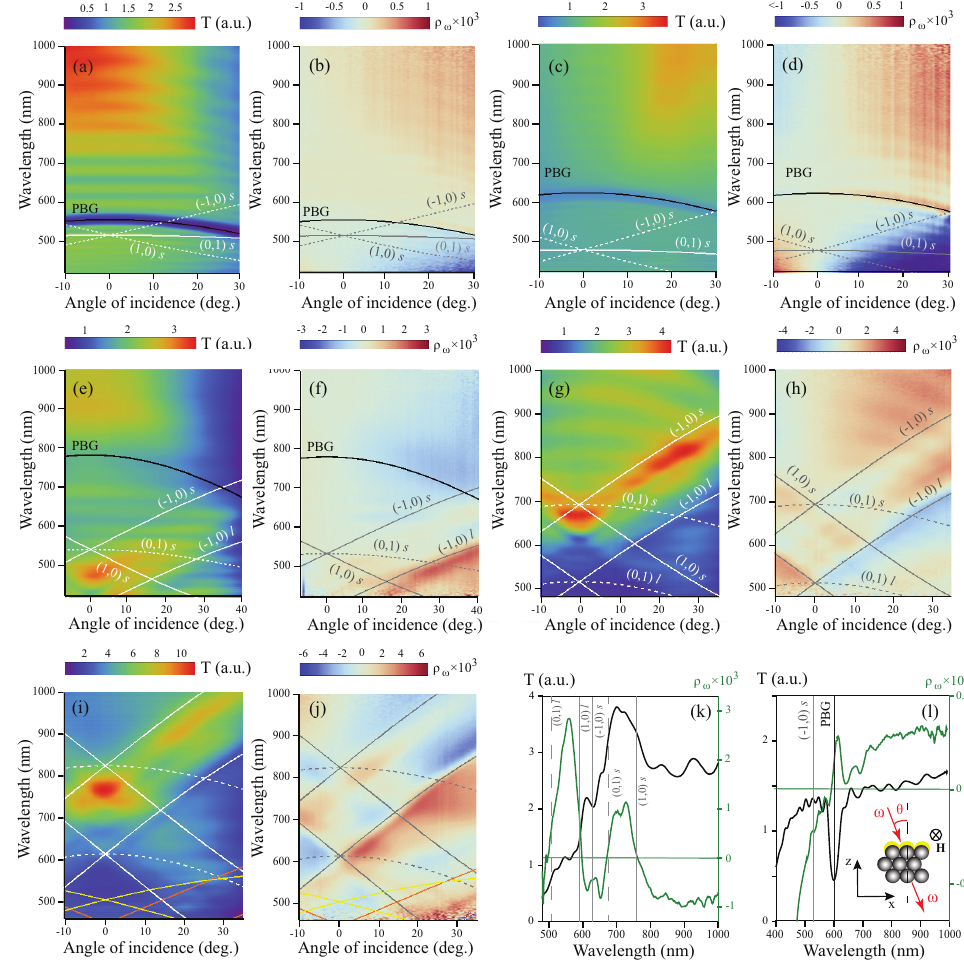
Figure 2. Angular-wavelength spectra of the transmission and magnetic contrast in the Voigt geometry for the samples “1” ( a , b ), “2” ( c , d ), “3” ( e , f ), “4” ( g , h ), and “5” ( i , j ); ( k ) T ( λ ) (black curve) and ρ ( λ ) (green curve) for the sample “4” at θ = − 10 ◦ ; ( l ) T ( λ ) (black curve) and ρ ( λ ) (green curve) for the sample “2” at θ = 15 ◦ , inset: scheme of the experiment (yellow color is for Co